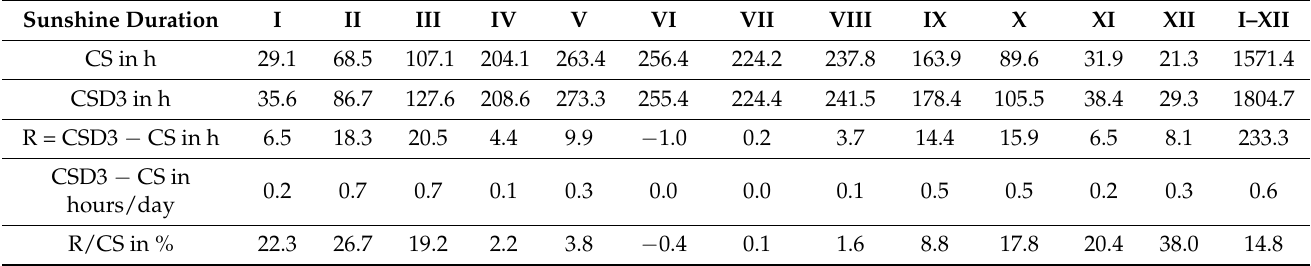
Table 3. Comparison of average monthly and annual sunshine duration recorded with the Campbell– Stokes recorder (CS) and the CSD3 sensor in Borucino, 2015–2021 (based on synchronous data).